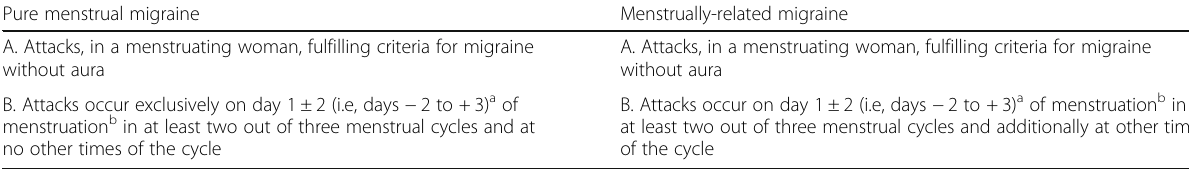
Table 1 IHS classification (ICHD-3) for pure menstrual and menstrually-related migraine Pure menstrual